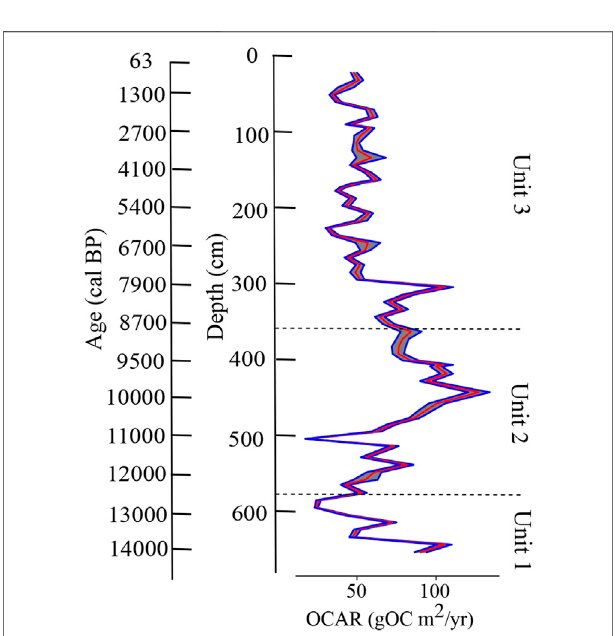
FIGURE 5 | Organic carbon accumulation rate (OCAR, in g OC m − 2 a − 1 ) for each biogeochemical subsample along the core (see Figure 4), inferred from the age-depth model, as well as sedimentation and mass accumulation rates (see Figure 2